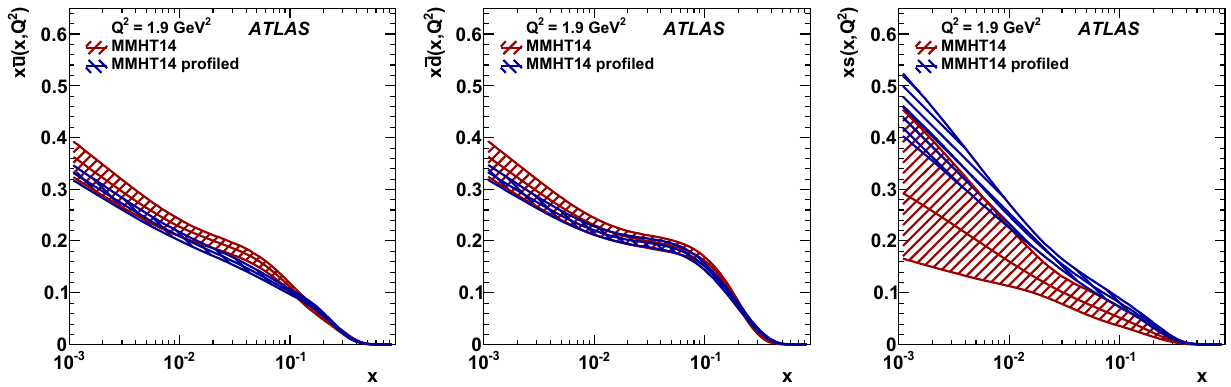
Fig. 26 Distribution of x ¯ u ( left ), x ¯ d ( middle ) and xs ( right ) PDFs as a function of Bjorken- x at a scale of Q 2 = 1 . 9 GeV 2 for the MMHT14 PDF set before and after profiling